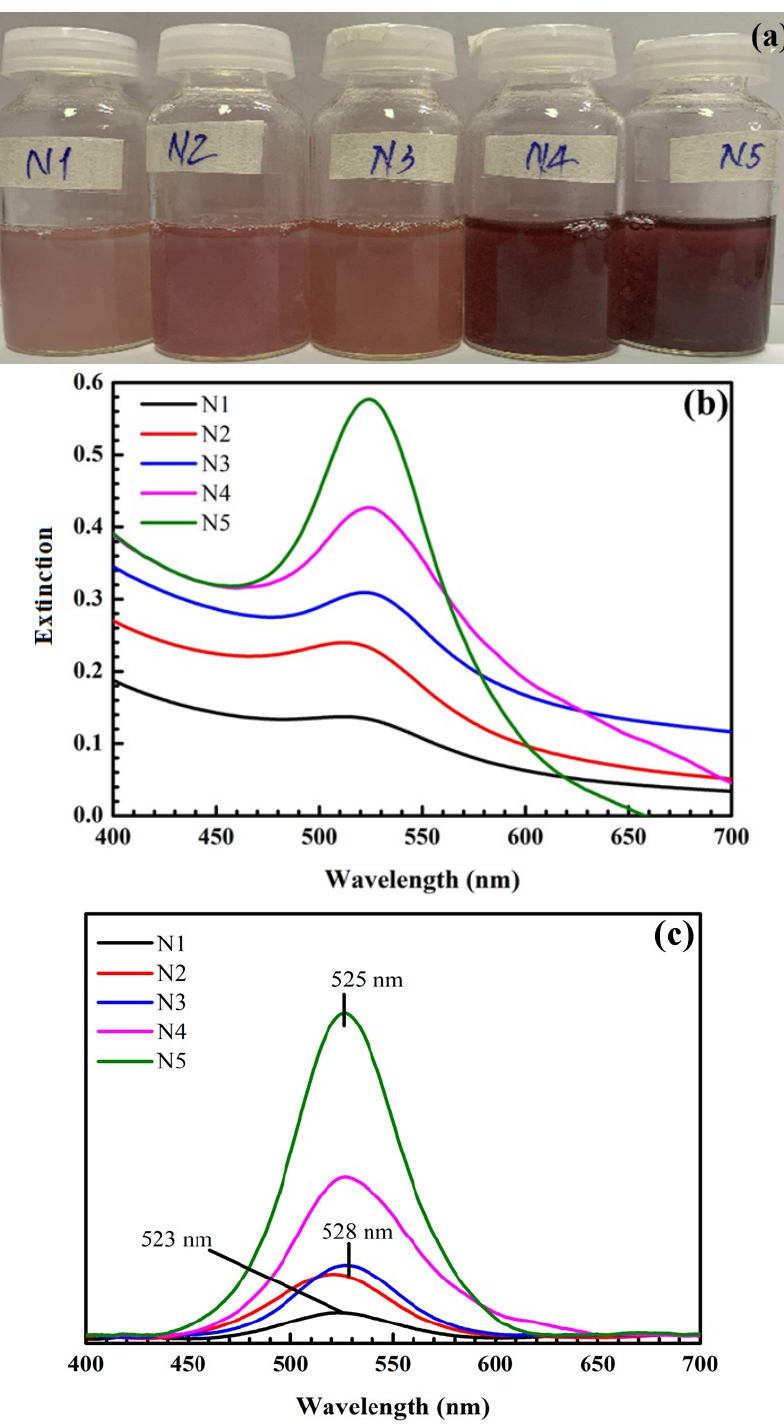
Figure 4. Pictures of samples at different concentrations of sodium citrate ( a ). UV-Vis spectra of samples at different concentrations of sodium citrate ( b ) and their UV-Vis baseline spectra ( c ). N1: 0.21 mM; N2: 0.42 mM; N3: 0.84 mM; N4: 1.5 mM; N5: 4.2 mM.